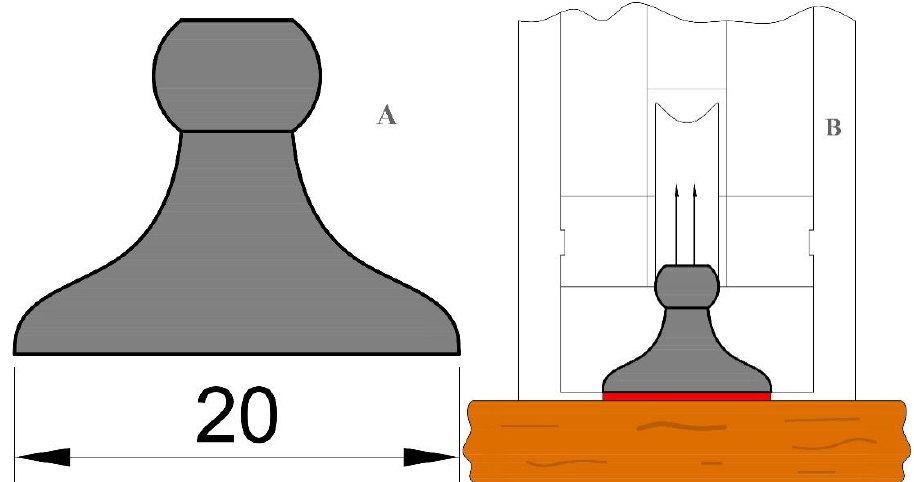
Figure 1. Schematic design of the apparatus to measure pull-off adhesion strength; ( A ) dolly with an effective diameter of 20 mm, ( B ) dolly assembled with adhesive on the substrate.